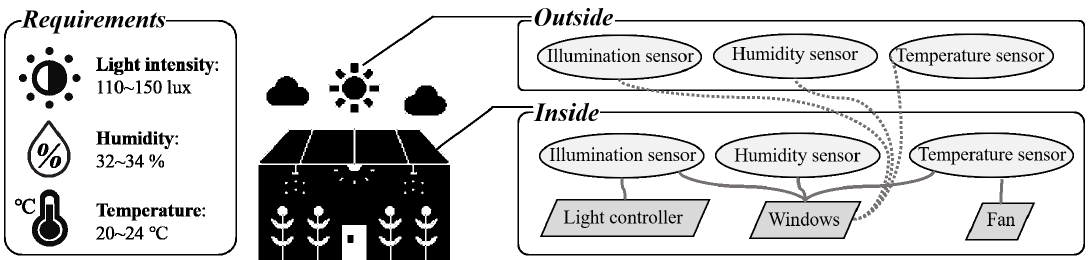
Figure 5. Overview of an IoT-based smart